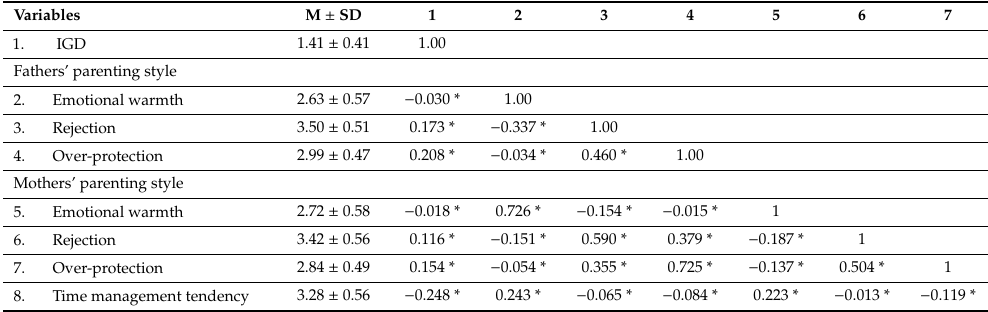
Table 1. Descriptive statistics and Pearson